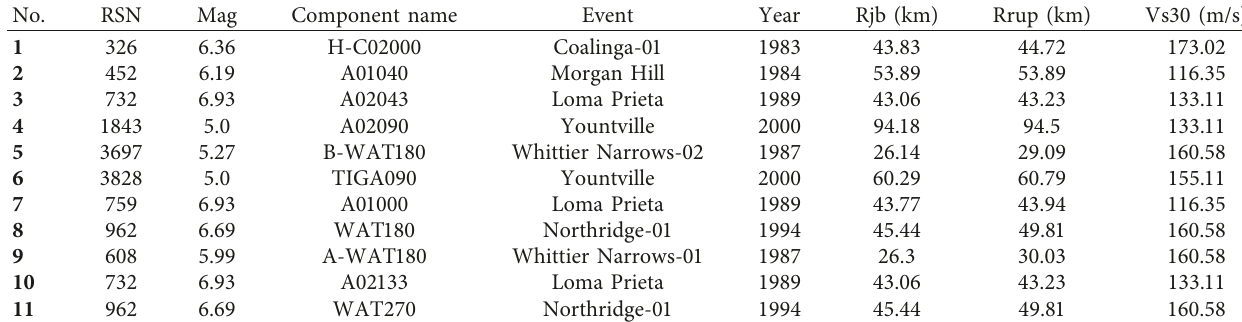
Table 3: Properties of acceleration records for time-history analysis.